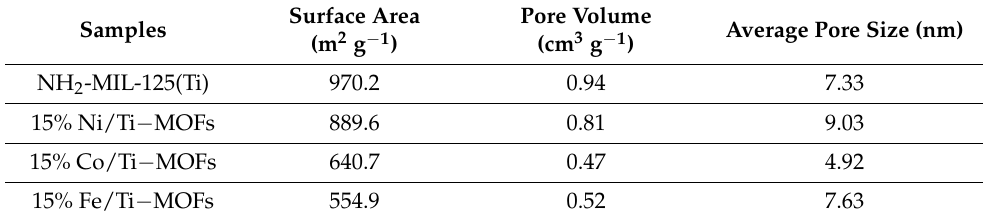
Figure 4. Adsorption–desorption isotherms ( A ) and pore size distribution ( B ) of NH 2 -MIL-125(Ti) and 15% M/Ti-MOFs (M: Ni, Co, Fe). Table 1. The textural properties of the different catalysts.